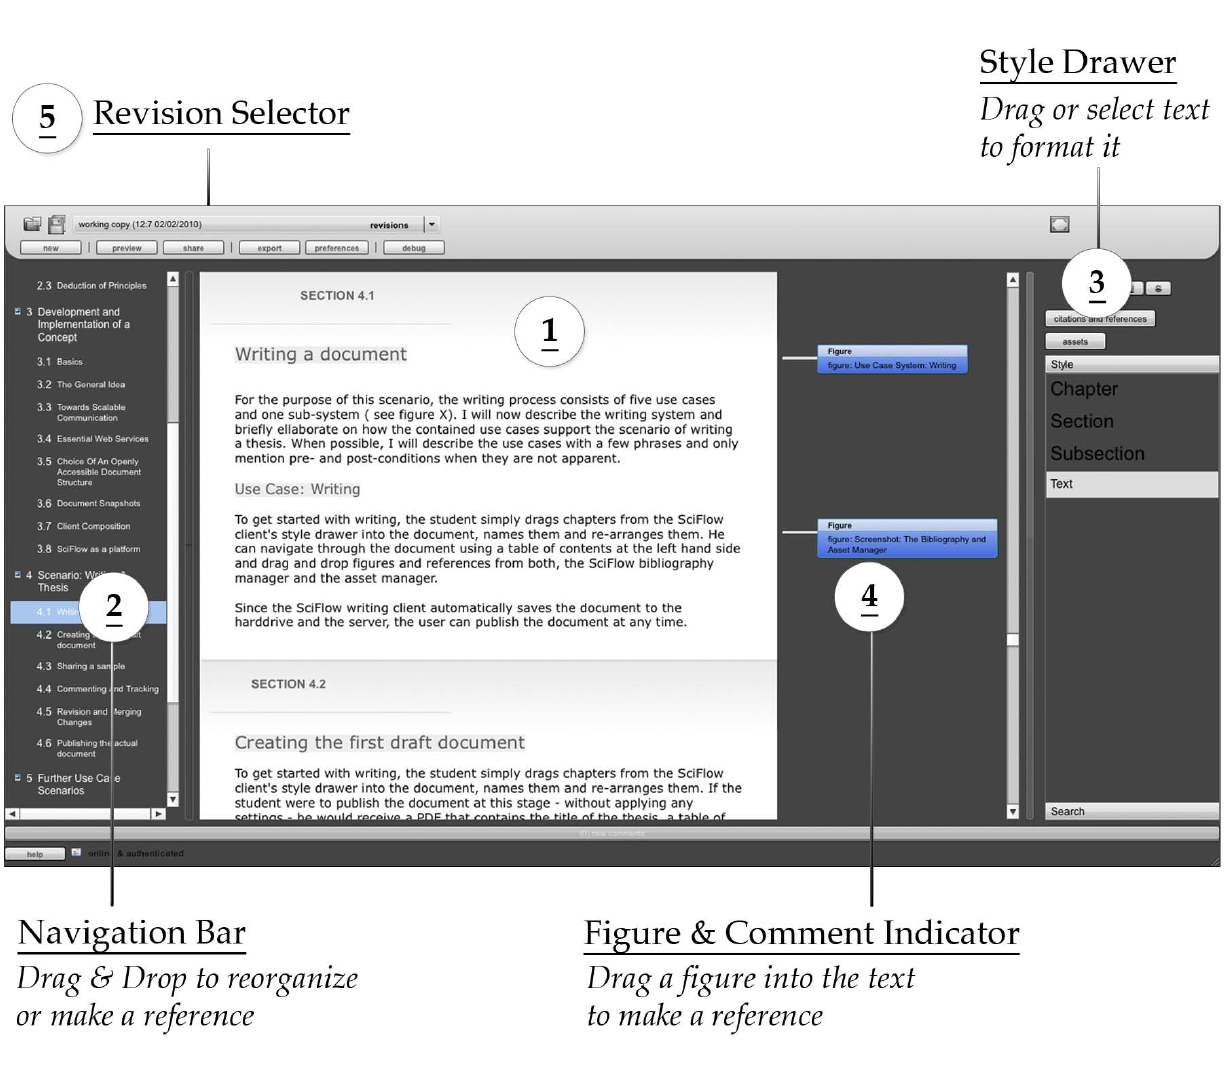
Figure 1. SciFlow writing